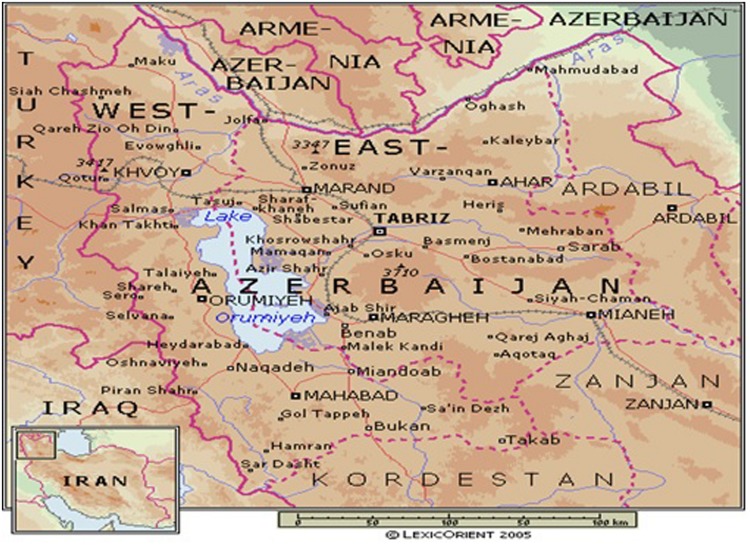
The study region was located in Northwestern Iran between 35 and 39°North latitude and between 46 and 48°East longitude.